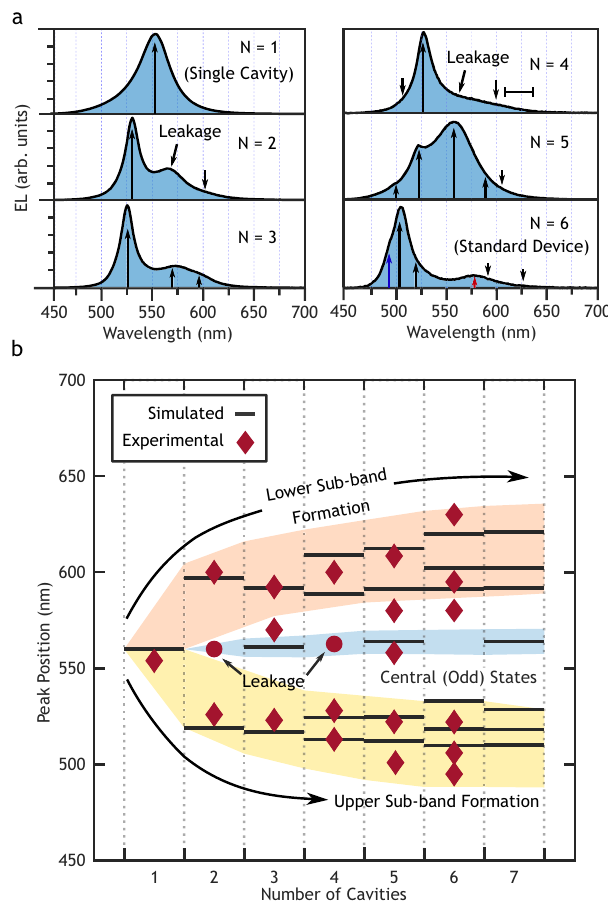
Fig. 2 Emergence of photonic bands. a Electroluminescence spectra at normal emission for N = 1 → 6 stacked microcavity OLEDs. The highest energy peak at 495 nm had a linewidth of 10.5 nm (blue arrow) while the highest energy peak in the lower sub-band at 578nm had a linewidth of 47nm (red arrow). b Computationally simulated and experimentally resolved wavelength of the center of each state in the photonic bands as a function of N . States separate into two sub-bands due to the dual cavity unit